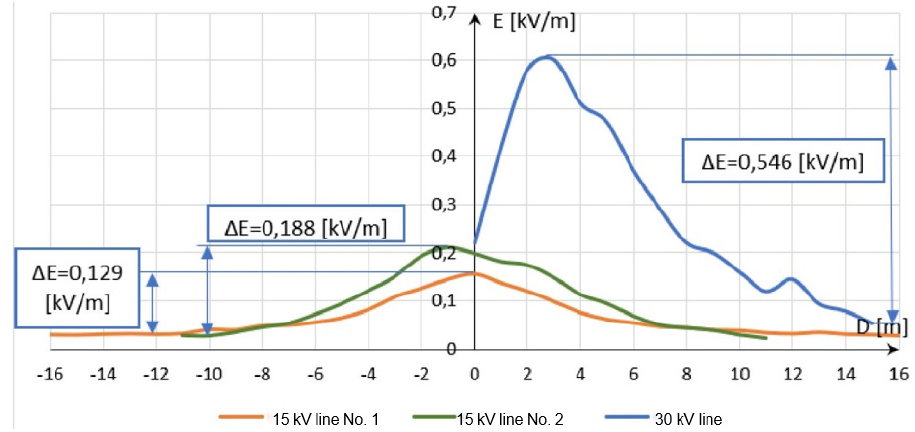
Figure 11. Distribution of electric field strength E across the line, for measuring point No. 1 and the ELF frequency range (induction measuring methodology as in Figure 2).